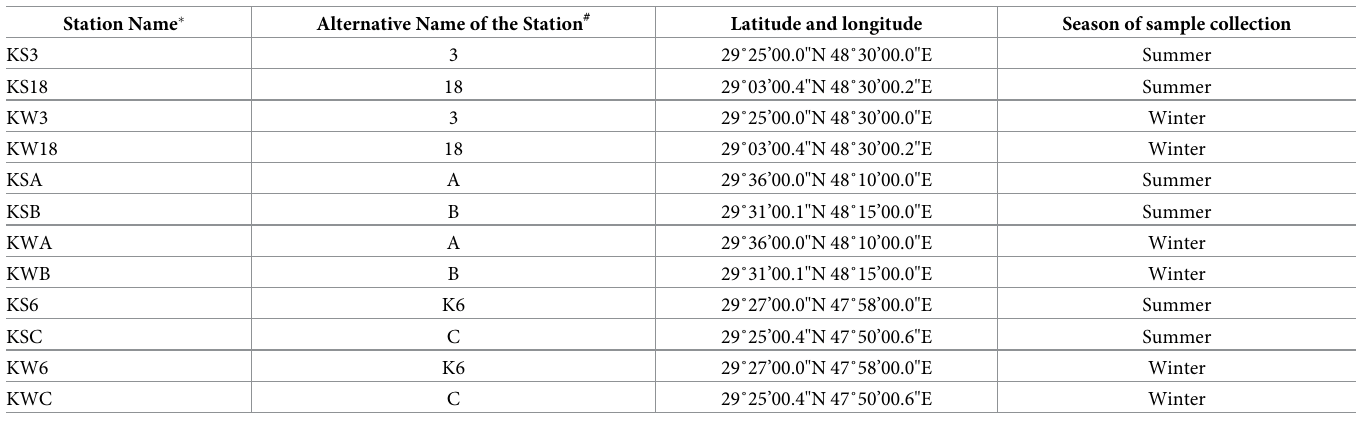
Table 1. Details of the samples and collection